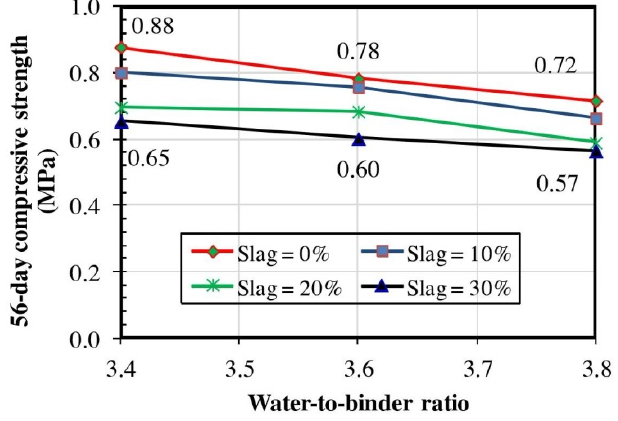
Figure 3. The 56-day compressive strength of CLSMs produced using SSRS and cement with respect to the water–binder ratio [98].